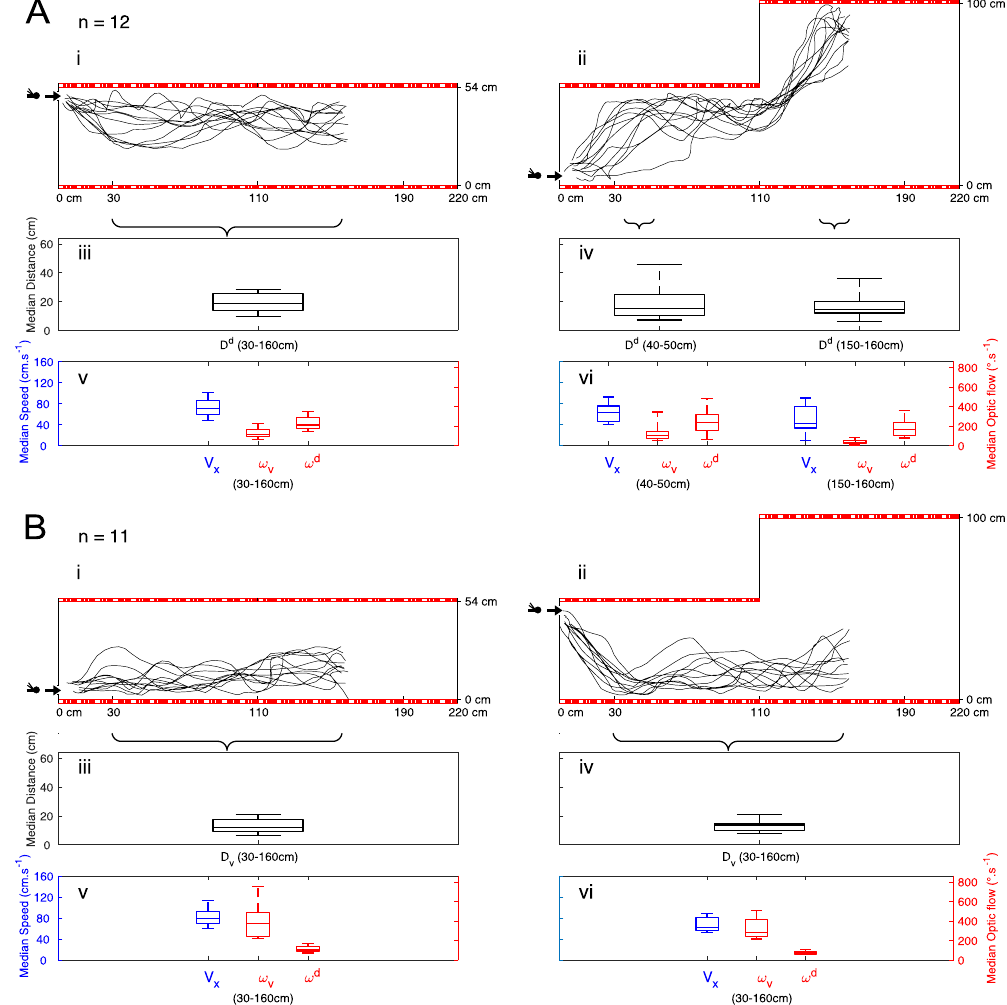
Figure 2. Step 0: E Top → R Top ; Step i: E Top ; Step ii: E Bottom . ( A ) Trajectories of honeybees ( n = 12) trained to enter the tunnel via the upper entrance before being released again via the upper entrance under low-roof conditions, as described in i and then released via the low entrance under “dorsal ditch” conditions, as described in ii. In the flight performed under “dorsal ditch” conditions which they had not previously experienced, the honeybees flew upward from the low entrance and followed the low roof and then continued to follow the newly encountered higher roof at an median distance D d (see boxplots in iii and iv) which did not differ significantly from previous condition. Distributions of median speed v x and median dorsal optic flows ω d (see boxplots in v and vi) were also not significantly different each others, when the ascent speed is low. ( B ) Step 0: E Bottom → R Bottom ; Steps i&ii: E Top . Trajectories of honeybees ( n = 11) trained to enter the tunnel via the lower entrance before being released again via the lower entrance under low-roof conditions, as described in i and then via the upper entrance under “dorsal ditch” conditions, as described in ii . In the flight performed under “dorsal ditch” conditions which had not been previously experienced, the honeybees immediately descended and followed the floor regardless of the presence of the dorsal ditch, at median distances D v (see boxplots in iii and iv) which did not significantly differ from that recorded under low-roof conditions. Distributions of median speed v x and median ventral optic flow ω v (see boxplots in v and vi) were also not significantly different each others. (See statistics in results and discussion